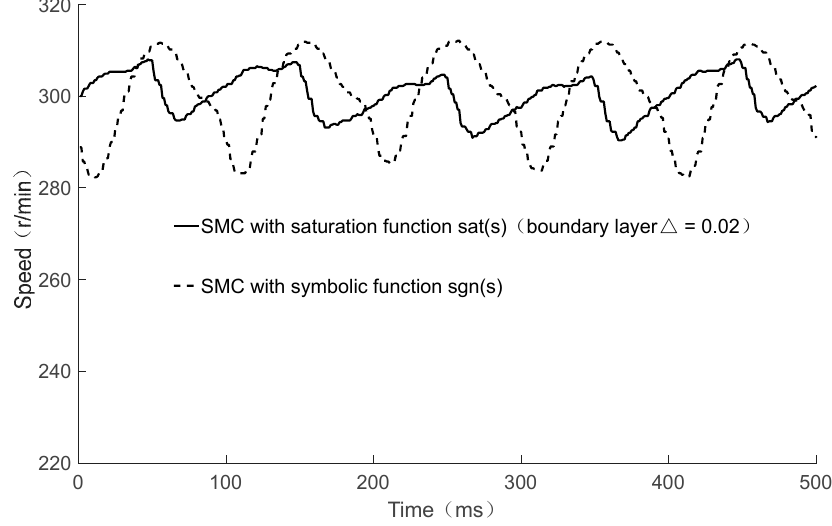
( ) s sat can improve the